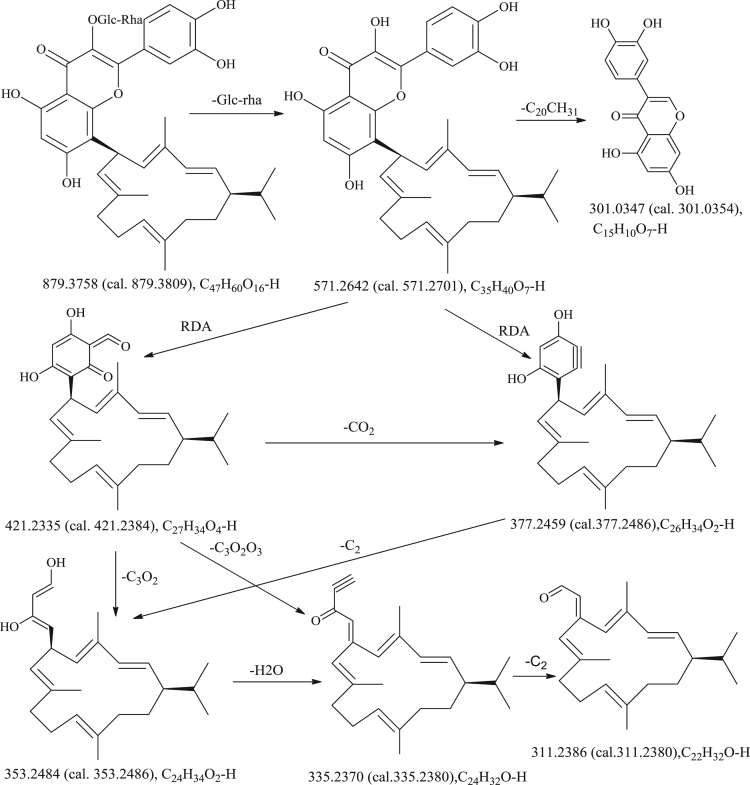
The MSn fragment pathways.